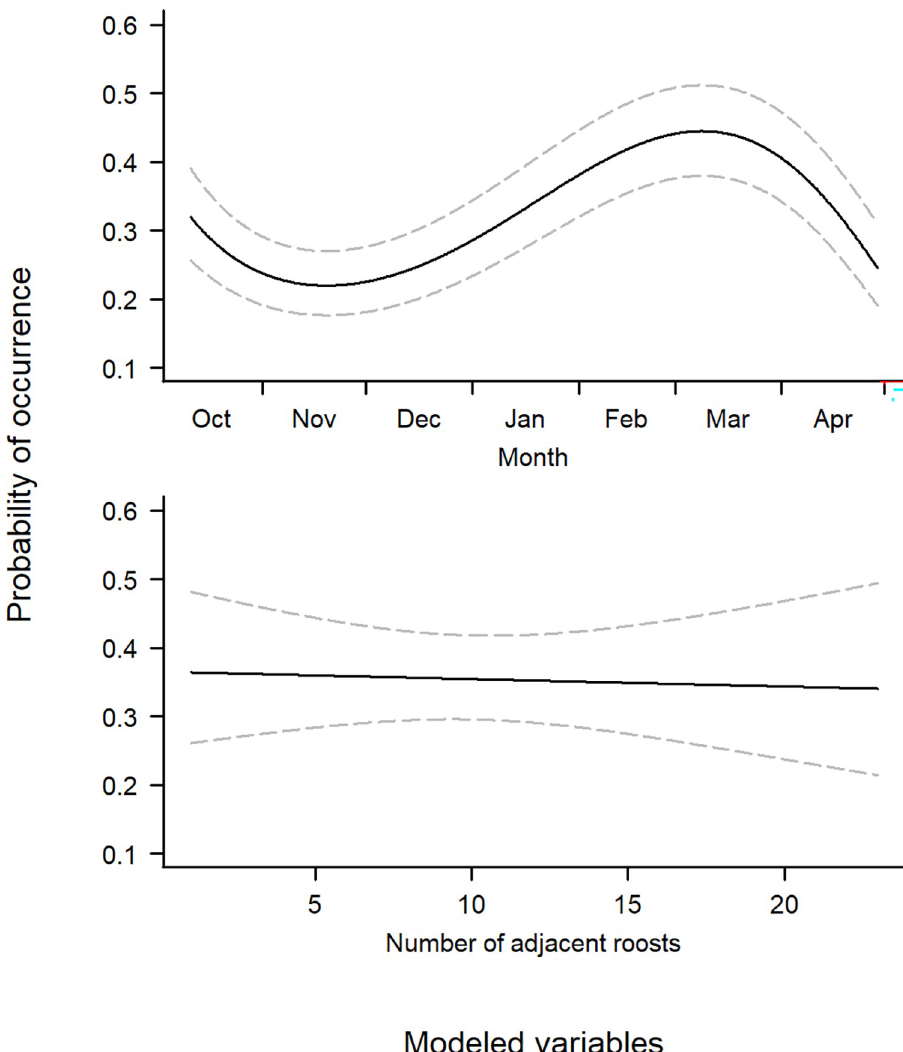
Fig 2. Predicted occurrence probability (+ 95% CI) of cormorants at roosting sites in the Mississippi Delta in relation to date, and the number of other roosts within a 23.4 km buffer. Trend lines were created from model predictions made by allowing each variable of interest to vary over its range and holding all other variables at their